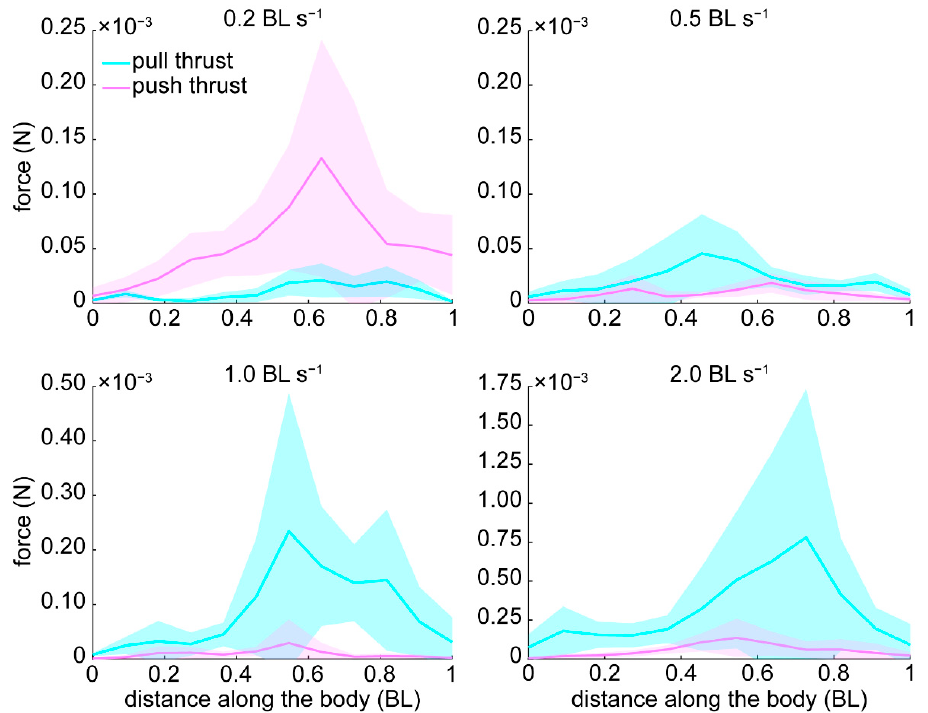
Figure 7. Distribution of push and pull forces along the body during one tail-beat cycle. Mean thrust components plotted against normalized body length (BL) for swimming speeds of 0.2 BL s − 1 , 0.5 BL s − 1 , 1.0 BL s − 1 , and 2.0 BL s − 1 . Shading indicates standard deviation.